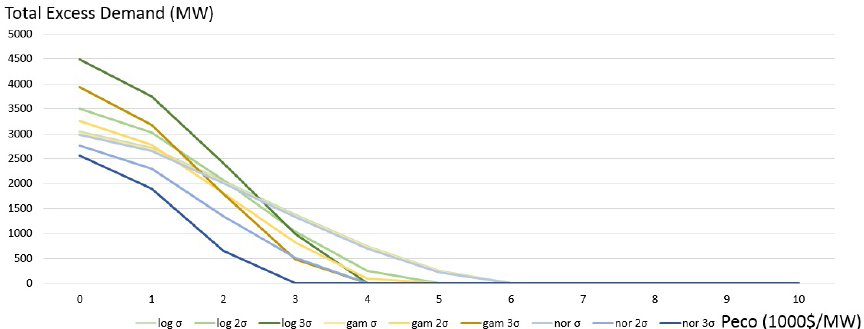
Figure 16. Variation of the optimal total excess demand with respect to P eco and σ for the different distributions (own